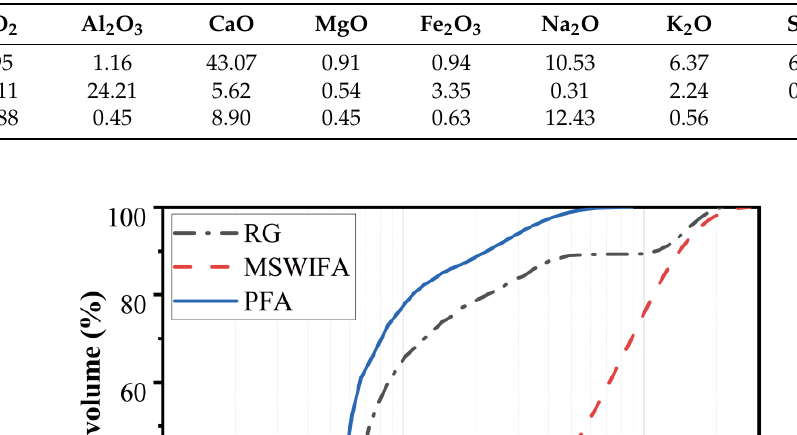
Figure 3. Raw material particle size. Table 1. The chemical compositions of raw materials.